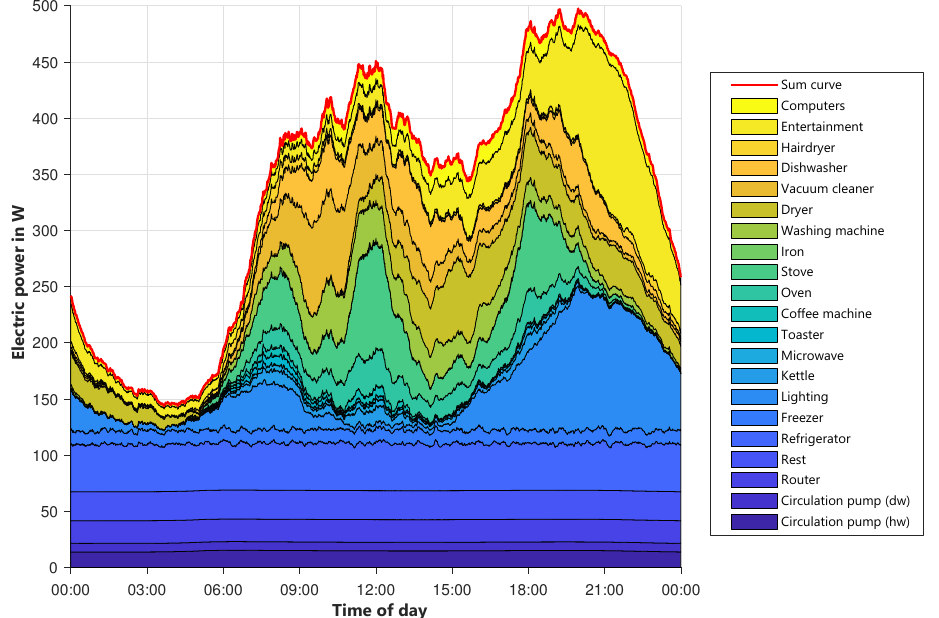
Figure A6. Layered load profiles of devices for type of day